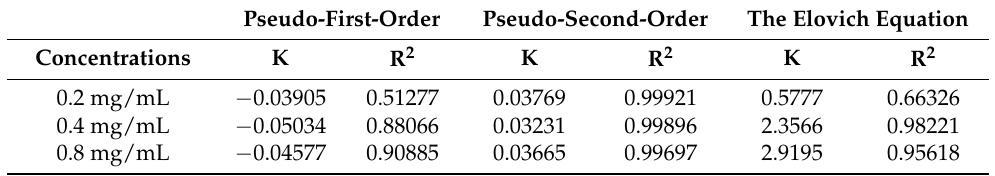
Table 2. The kinetic parameters of BF adsorption on 1 .